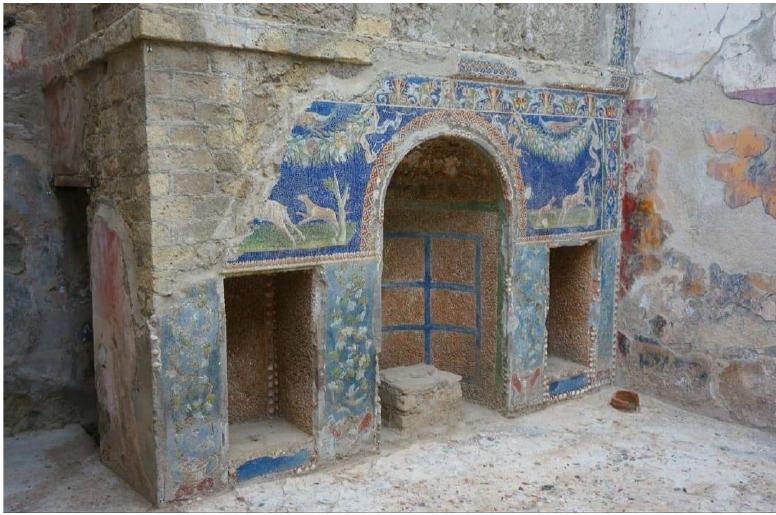
Figure 5. View of the interior of the domus of Neptune and Amphitrite [31].